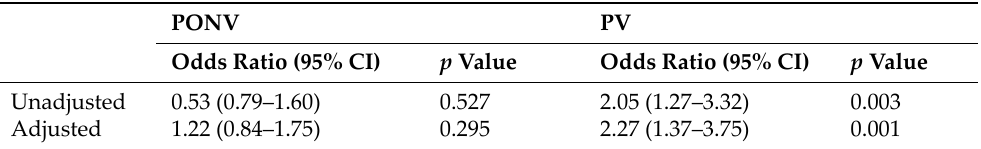
Table 5. Odds ratio for pregnancy on developing PONV and PV in reproductive female patients who underwent nondelivery surgery after propensity score matching. PONV PV Odds Ratio (95% CI)